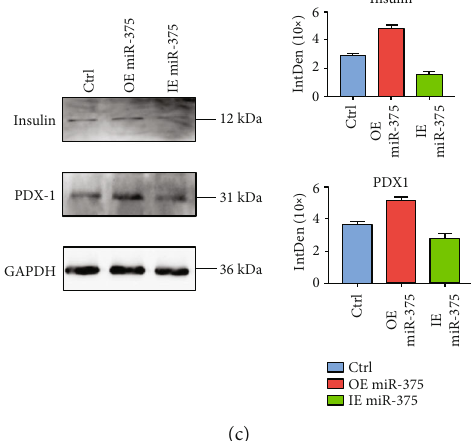
Figure 2: The e ff ects of miR-375 overexpression and inhibition during di ff erentiation of human embryonic stem cells to insulin-producing cells. (a) Illustration of the transfection process. We used liposomes to perform transfection of miR-375 mimics and miR-375 inhibitors at the beginning of each phase (D0, D4, D7, D11, D14, and D18). Samples were collected at the end of each stage (D3, D6, D10, D13, D17, and D21). (b) The e ff ect of the miR-375 mimic and miR-375 inhibition on transcription factors. (c) Western blotting detection and grayscale analysis were used to determine the protein expression of PDX-1 (D13) and INSULIN (D21) after miR-375 overexpression and